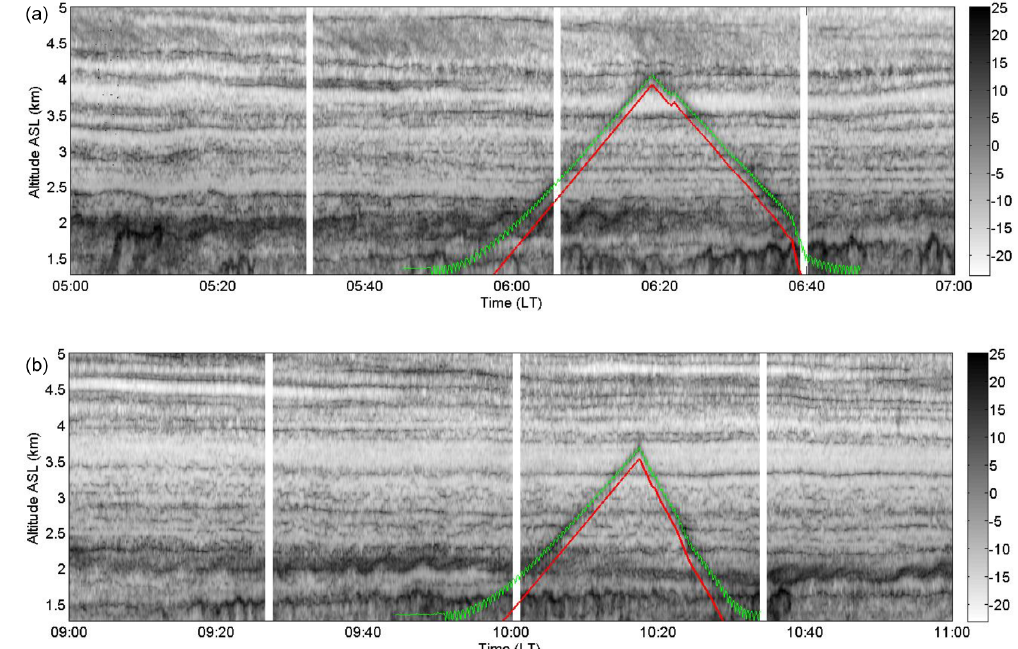
Figure 3. (a) Time–height plot of MU Radar echo power at vertical incidence from 05:00 to 07:00LT on 7 June 2015, corresponding to flight UAV4. The red (green) line shows the altitude (distance) of the UAV versus time. (b) Same information but for flight